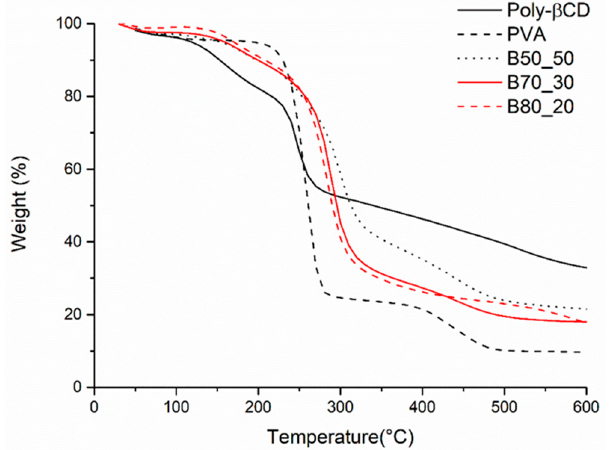
Figure 3. TGA curves of Poly- β CD (red solid line), PVA (red dashed line), B50_50 (black solid line), B70_30 (black dashed line), and B80_20 (black dotted line).